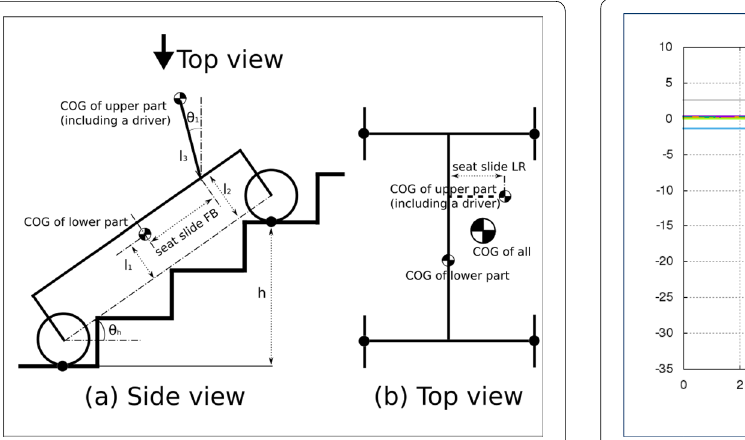
Fig. 9 Data 2 during the stair-climbing